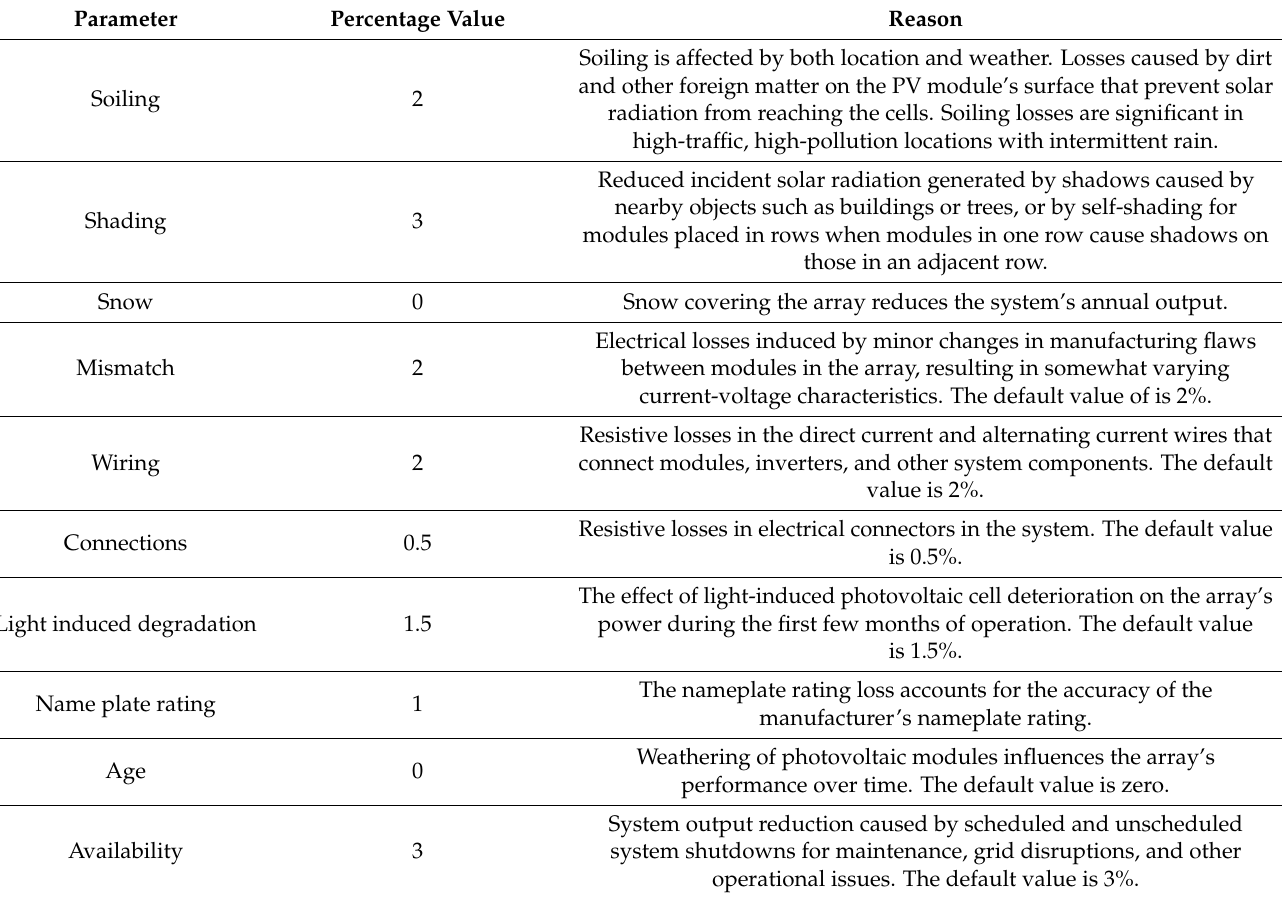
Table 4. System loss